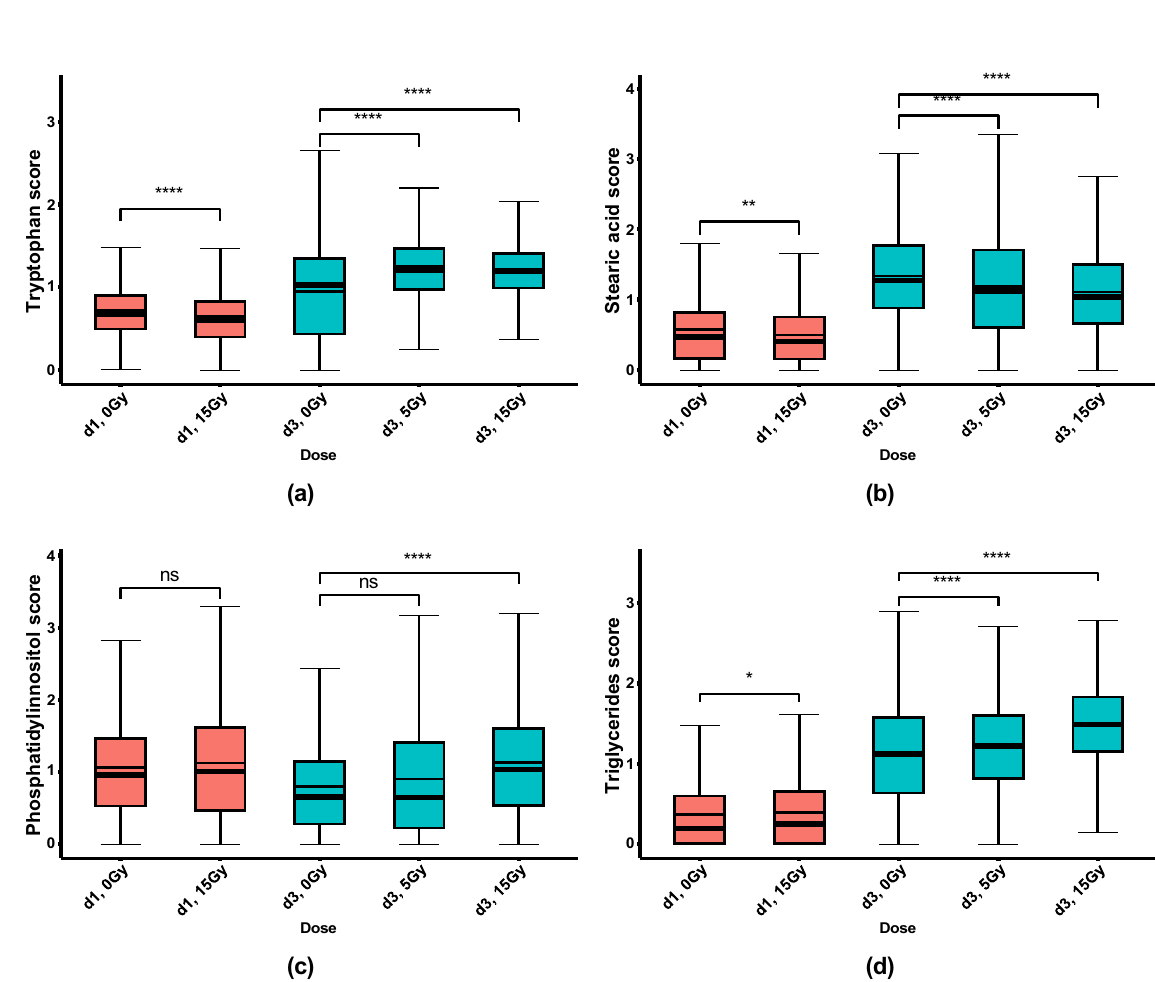
Figure 4. Box plots showing mean (thick line) and median (thin line) ( a ) Tryptophan, ( b ) Stearic acid, ( c ) Phosphatidylinnositol, ( d ) Triglycerides GBR-NMF scores for breast tumour xenografts exposed to 0, 5, and 15 Gy and harvested 1 and 3 days post-irradiation. Significance stars represent statistically significant score changes according to Wilcoxon’s unpaired test (*p < 0.05, **p < 0.01, ****p < 0.0001, ns = not